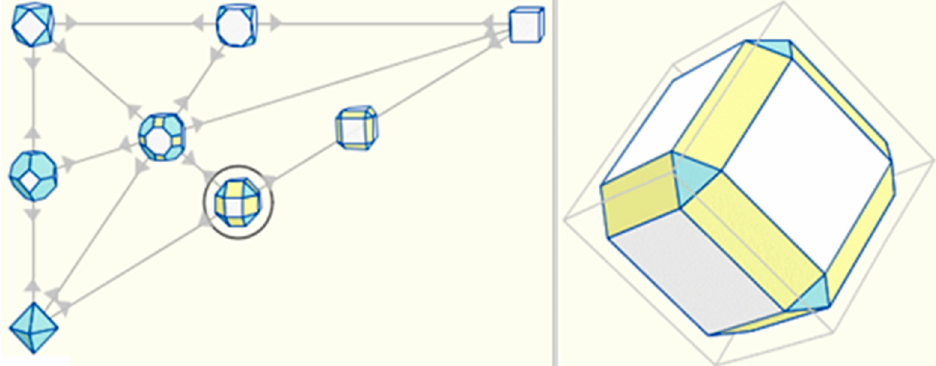
Figure 4. An interface in which transition is distributed ( left ) and stacked ( right ). From the tool used in [65].